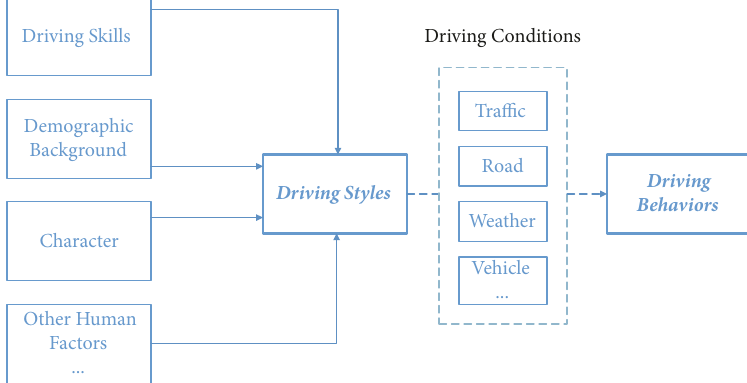
Figure 1: Schematic graph for the demonstration of the relationships between the key terminologies used in this